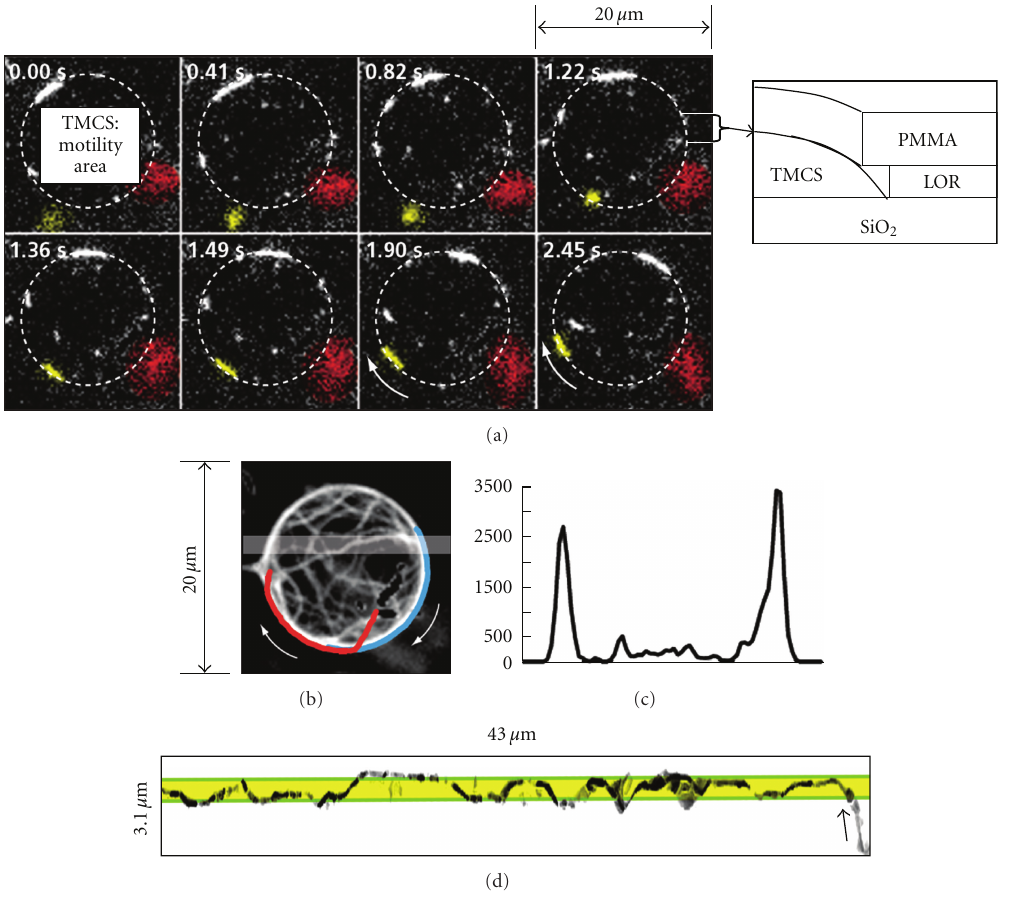
Figure 4: Experimental demonstration of the edge-tracing e ff ect. (a) A time sequence of fluorescence micrographs showing actin filaments moving on a disk-shaped motility supporting TMCS surface surrounded by hydrophilic and negatively charged PMMA (see inset with schematic illustration of topography between full white lines in rightmost micrograph in first row). The lack of actin binding on PMMA indicated by red and yellow filaments floating in solution. Note that several of the HMM-propelled actin filaments on the disk-shaped TMCS-derivatized region move along the border of the motility supporting area. (b) Fluorescence micrograph integrated over 60s to show sliding trajectories of 8 motile filaments (4 stationary filaments) sliding at velocity of about 3 μ m/s. (c) Intensity profile indicating the density of actin filaments along the gray area in (b). (d) Time-integrated and color-enhanced fluorescence micrograph illustrating path of a filament (length 3 . 5 μ m) entering a channel (yellow-green area) from an open zone at the arrow. The image is not to scale but magnified 2 x vertically in order to more clearly illustrate the lateral position of the filament inside the channel. Green: approximate bottom channel borders (width 700nm; LOR walls). Yellow: approximate top channel position (width 600 nm; with PMMA walls) for the type of channels illustrated in Figure 1. Figure 4(d) reproduced from [27] (DOI: 10.1088/0957-4484/16/6/014) with permission from Institute of